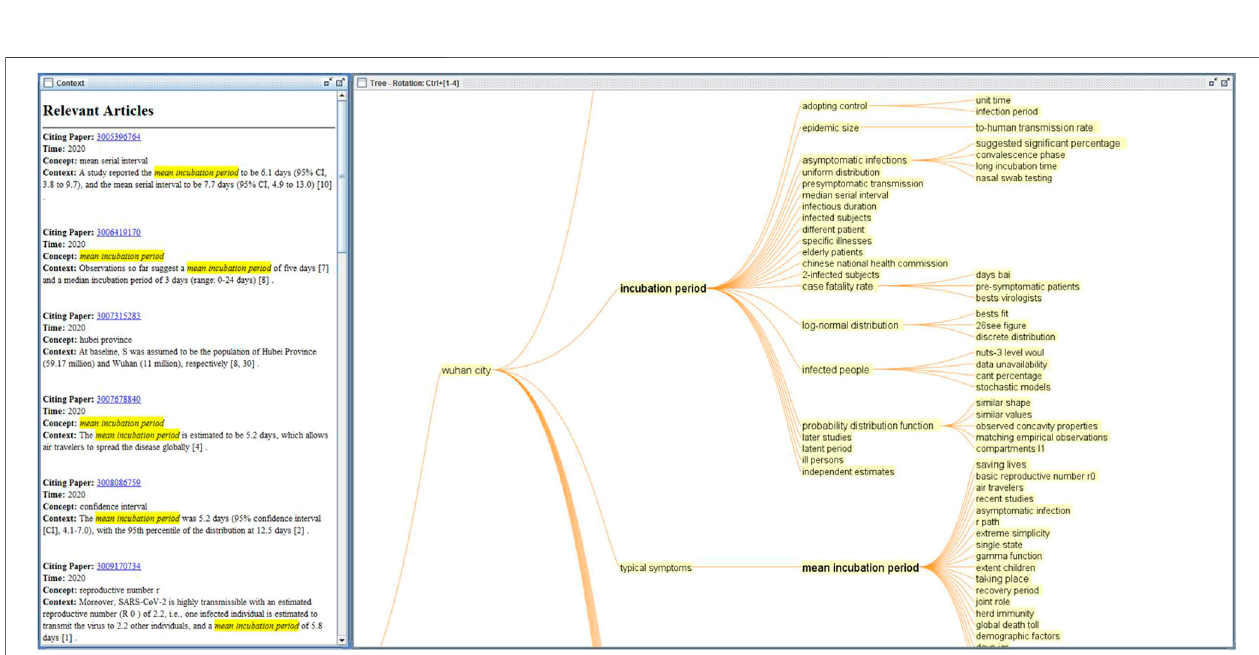
FIGURE 3 | Making sense of major themes of citations to a speci fi c reference Li Q. (2020).